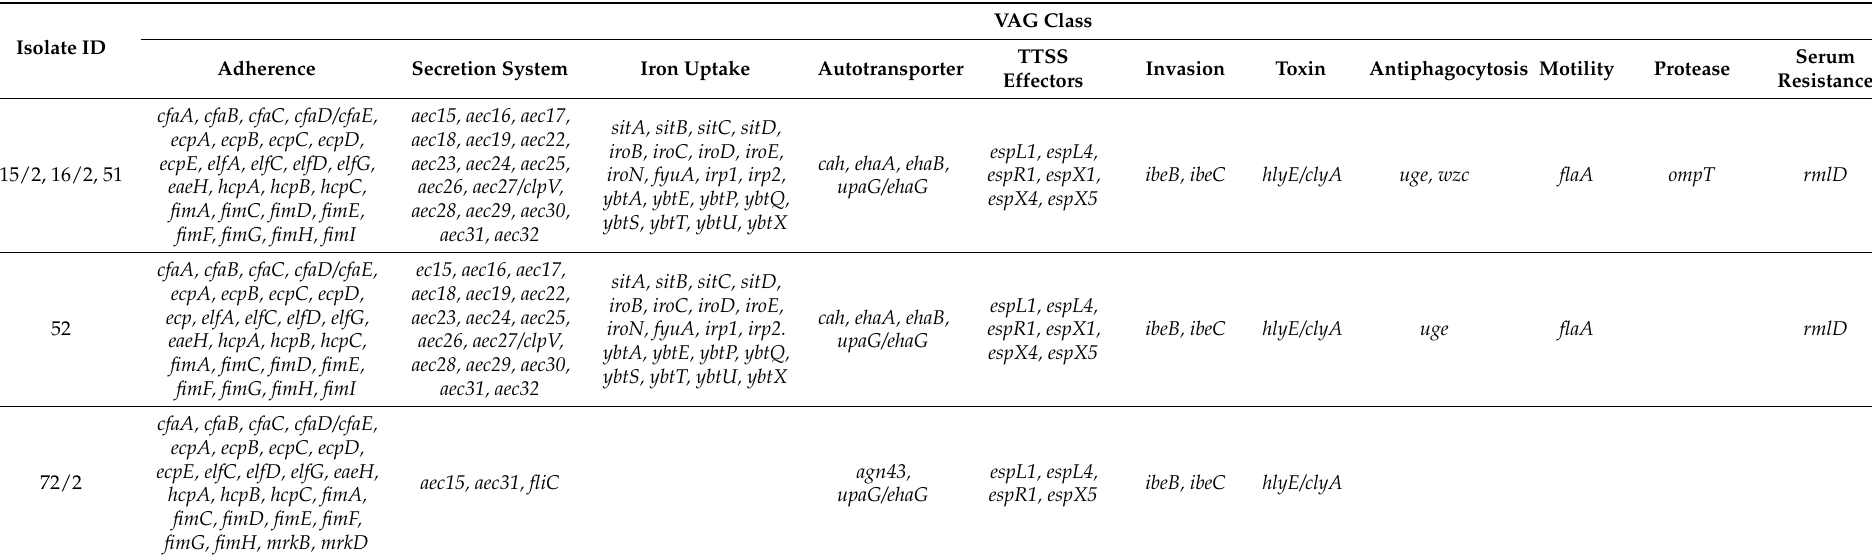
Table 2. VAGs detected in the mcr-1.1 -carrying E. coli